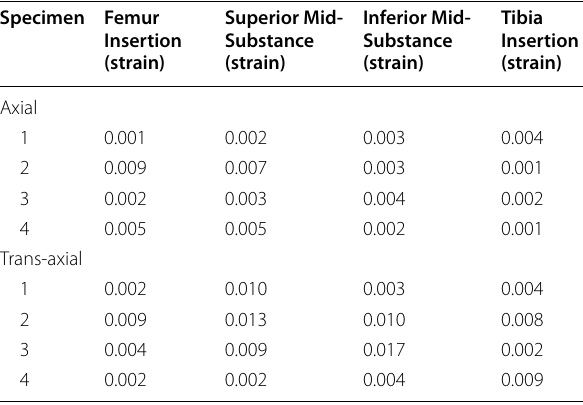
Table 3 The mean of the standard deviations for the axial and trans-axial strains measured across repeated trials for each region of the ligament, for each specimen. This represents a mean of all load conditions tested for each specimen Specimen Femur